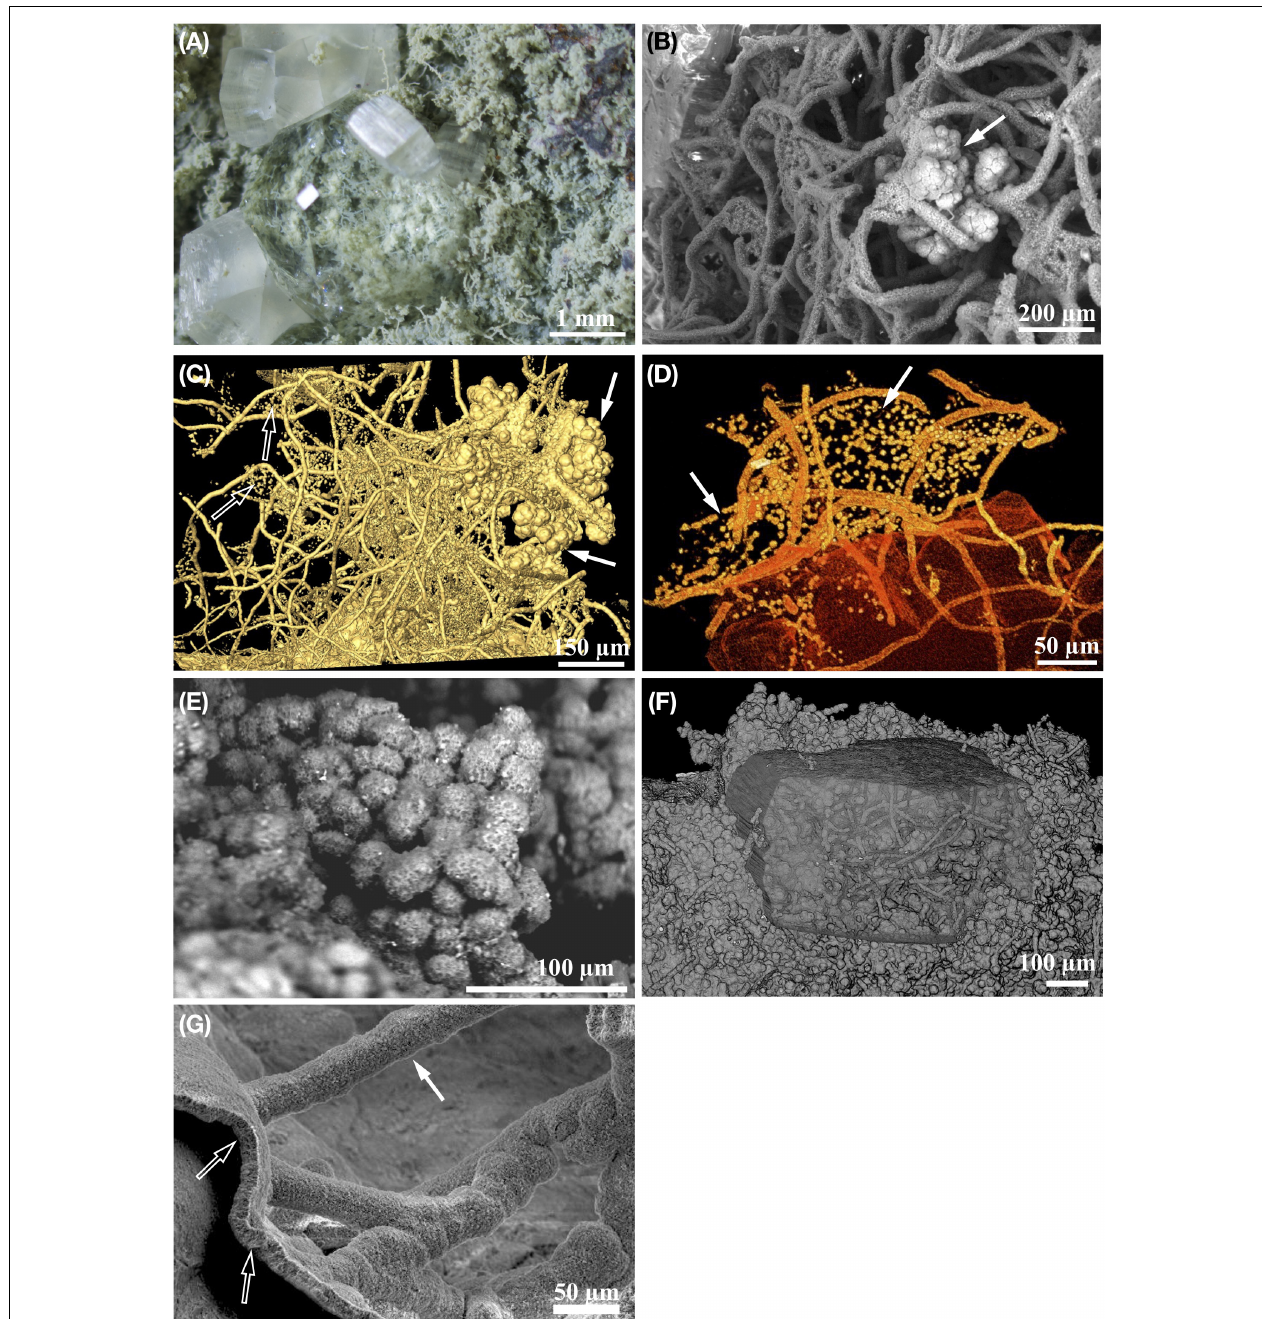
FIGURE 3 | Eukaryotic and prokaryotic fossils found in deep subsurface basaltic habitats. Panels (A,E) are ODP sample 197-1205-34R-5 from Nintoku Seamount. Panel (F) is sample 197-1205-34R-5, 33 also from Nontoku Seamount. Panels (B,D) are ODP sample 197-1206-4R-2 from Koko Seamount, and (C) ODP sample 197-1206-4R-2 from Koko Seamount. Panel (G) is ODP sample 197-1204B-16R-01, 145 from Detroit Seamount. (A) Stereomicroscope image of one side of an open fracture that has mechanically been split open. The fracture wall is covered by fossilized fungal mycelium mineralized by clays, which becomes partly buried by secondary zeolite mineralization. (B) Backscatter electron micrograph (ESEM-BSE) showing the symbiotic relationship between clay permineralized fungal mycelia and cauliflower-like microstromatolites (arrow) from subsurface basalt. (C) Microtomographic (SRXTM) surface rendering showing a symbiotic relationship between three-dimensional fungal mycelium, globular microstromatolites (filled arrow) and unicellular prokaryotes suspended in a cobweb-like manner between the hyphae (hollow arrow). (D) Partly translucent microtomographic (SRXTM) volume rendering of unicellular prokaryotes (arrow) suspended in cobweb-like layers, or sheets, in between fungal hyphae. (E) Backscatter electron micrograph (ESEM-BSE) showing clay permineralized globular yeast cells in subsurface basalt. (F) Partly translucent microtomographic (SRXTM) volume rendering of a fossil fungal biofilm consisting of fungal hyphae and globular yeast-cells. Note that the biofilm has been partly overgrown by zeolite. (G) Backscatter electron micrograph (ESEM-BSE) showing clay permineralized fungal biofilm and attached hyphae.